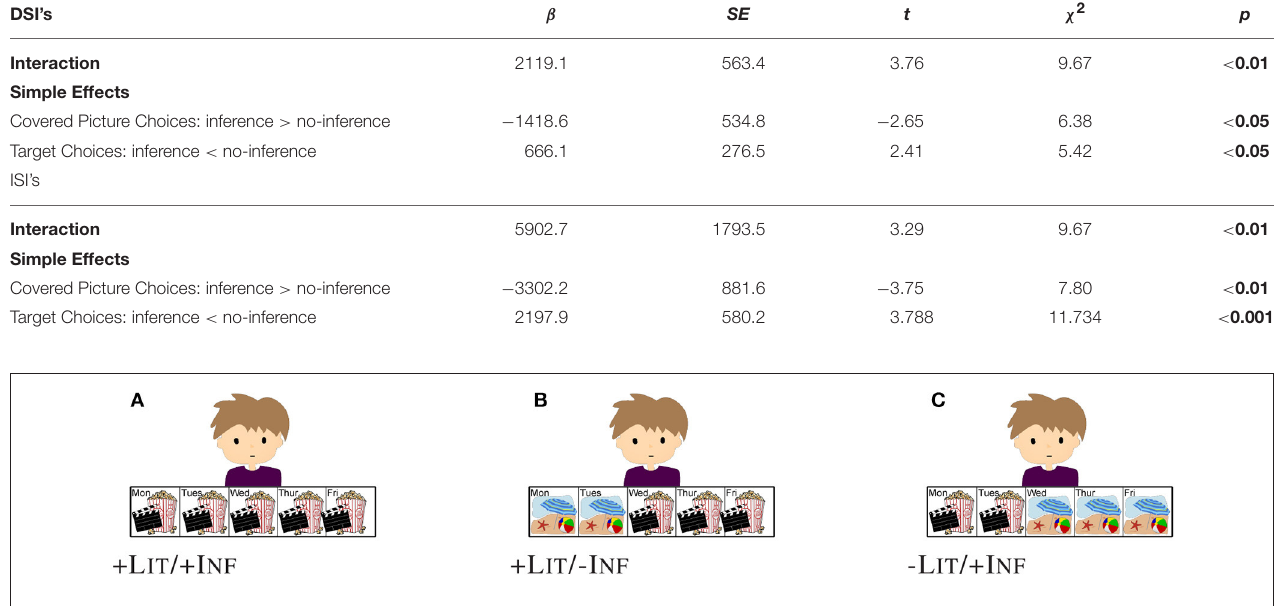
TABLE 2 | Summary of response time analyses: Interaction between Picture Choice and inference status and simple effects for relevant paired factor levels. DSI’s β